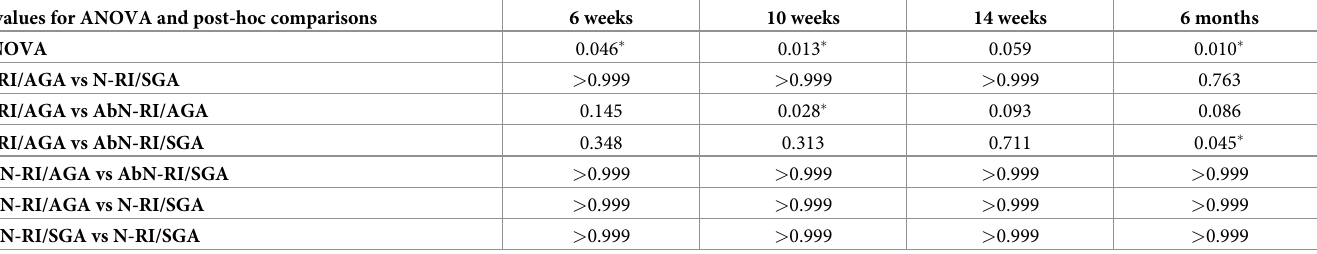
Table 4. ANOVA analysis with post-hoc comparisons of the infants’ fat-free mass in the first 6 months of life according to the umbilical artery RI and AGA/SGA classifications. P-values for ANOVA and post-hoc comparisons